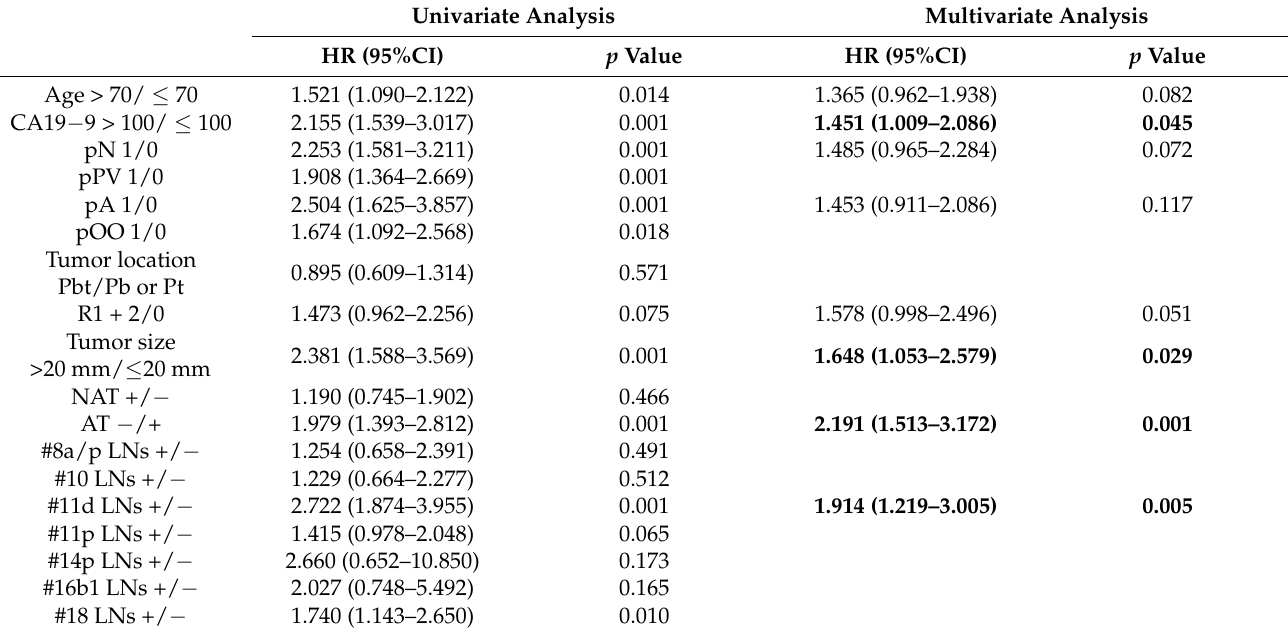
Table 3. Univariate and multivariate analyses of the influence of various factors on overall survival. Univariate